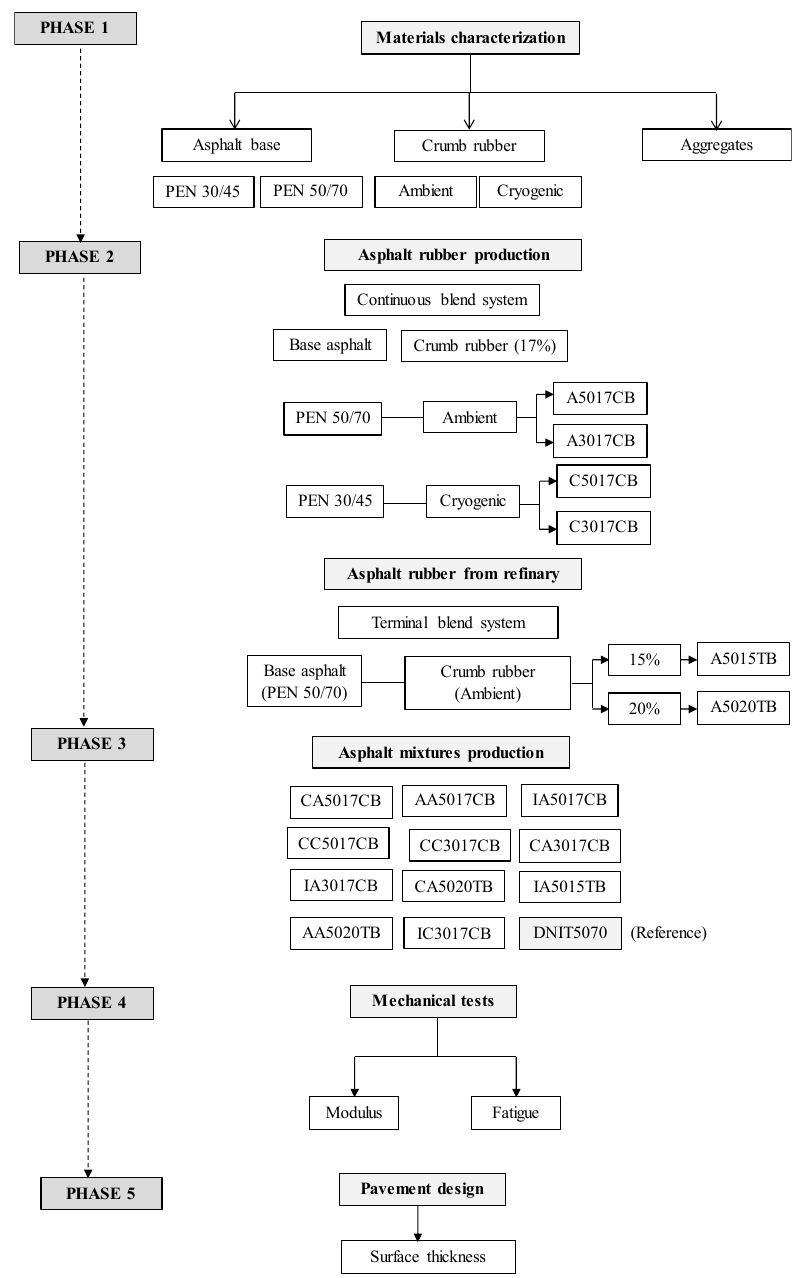
Figure 1. Flowchart of the method.